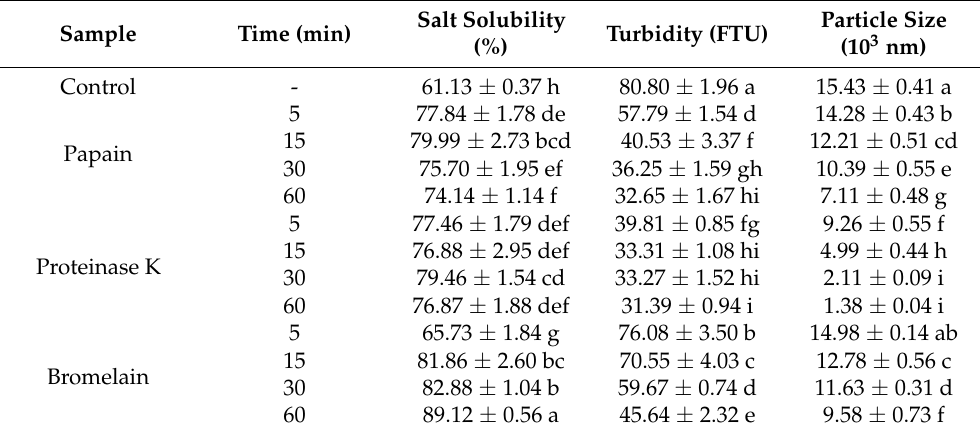
Table 1. Effect of different protease treatments on the changes in salt solubility, turbidity and particle size of